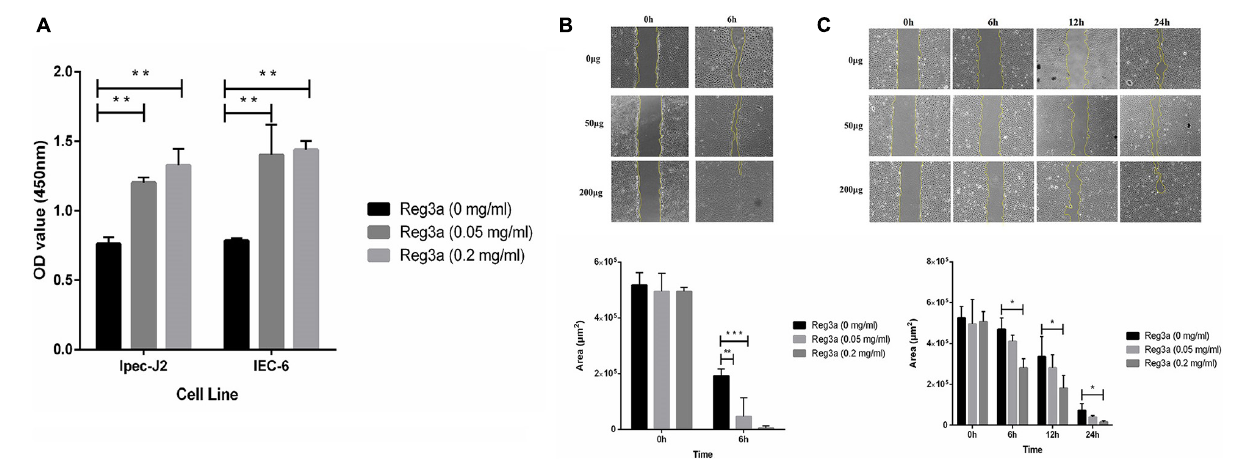
FIGURE 8 | The result of CCK8 assay and healing assay. The recombinant antimicrobial peptide Reg3a treated the Ipec-j2 cells and IEC-6 cells within 24 h. No antimicrobial peptide was used as control (A) . For healing assay, the recombinant antimicrobial peptide Reg3a treated Ipec-j2 cells (B) and IEC-6 cells (C) in 24 h. No antimicrobial peptide was used as control. Error bars indicate standard deviations. * p < 0.05, ** p < 0.01, and *** p < 0.001 were compared by Student’s t -test to evaluate differences between every two groups.